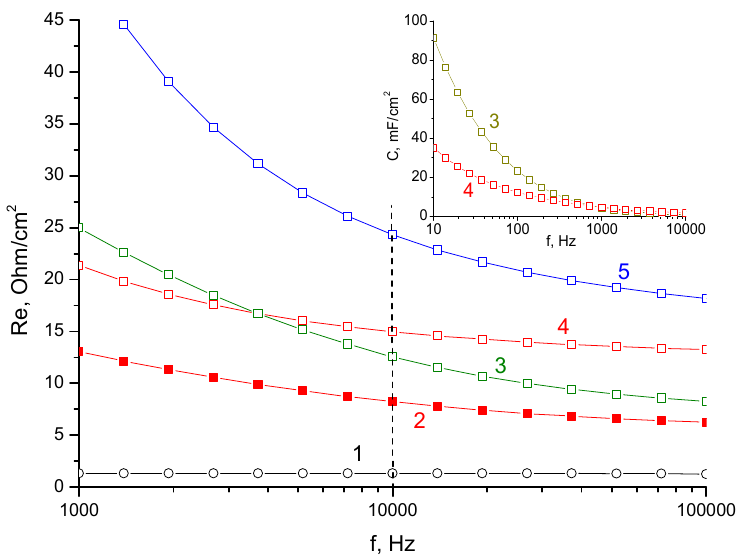
Figure 9. Dependence of resistance on the logarithm of frequency for: 1—intrinsic resistance of the measuring cell; 2—membrane soaked in 3M ZnBr 2 ; 3—membrane kept in water; 4—sample 2 washed in water; 5—membrane from battery cell 3 washed in water. The inset shows dependence of the measured capacitance for samples 3 and 4 on the logarithm of the frequency.